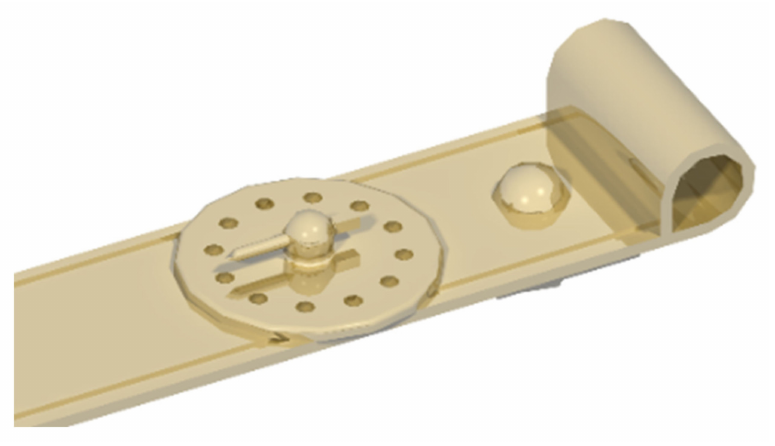
Figure 20. Dial on the sliding